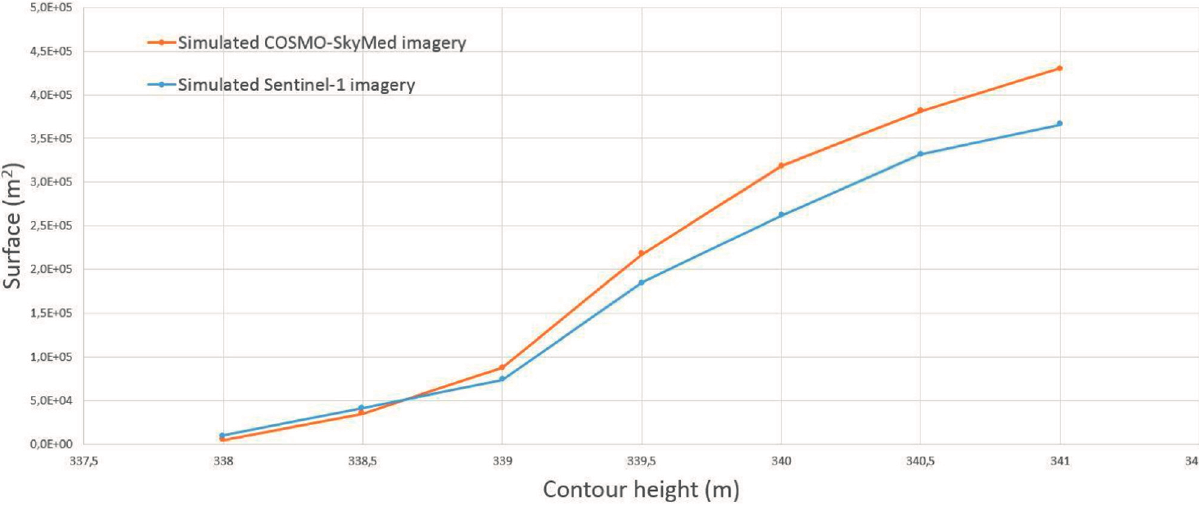
Figure 8. Laaba basin: Surface water as function of the contour height.